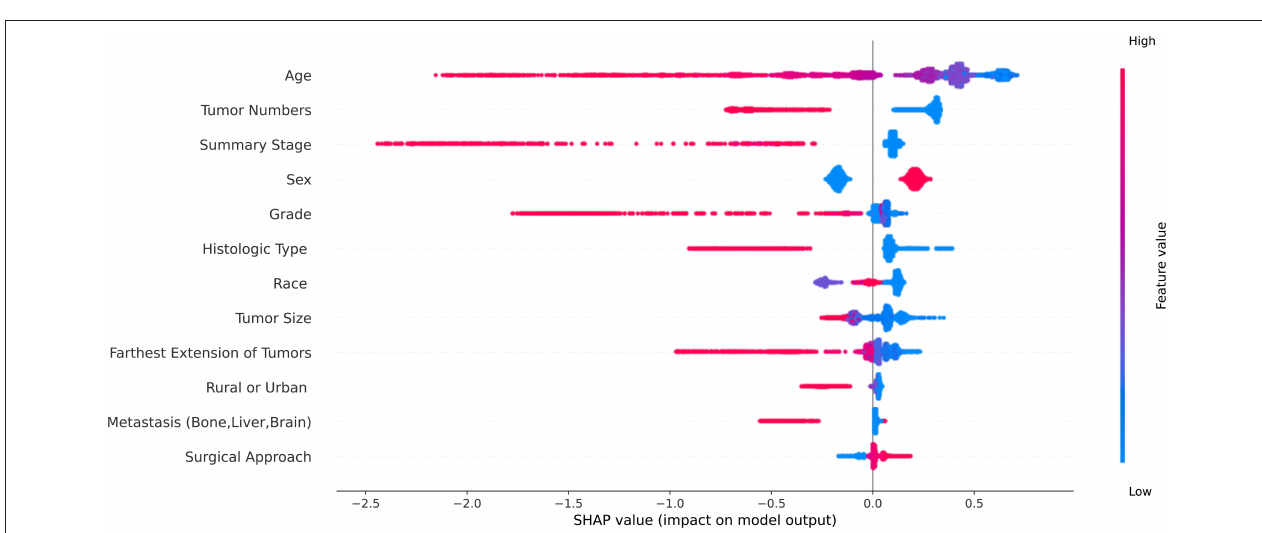
Frontiers in Surgery |